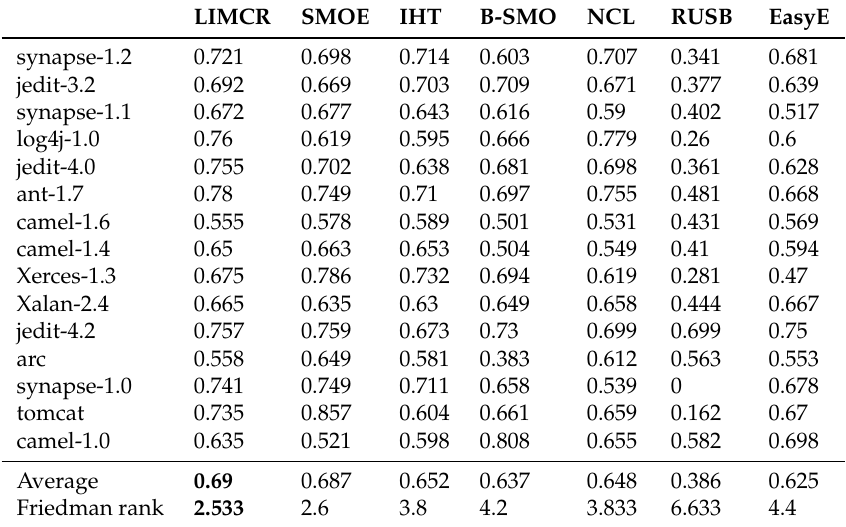
Table 9. G-mean of GNB with different imbalance learning methods on small datasets.